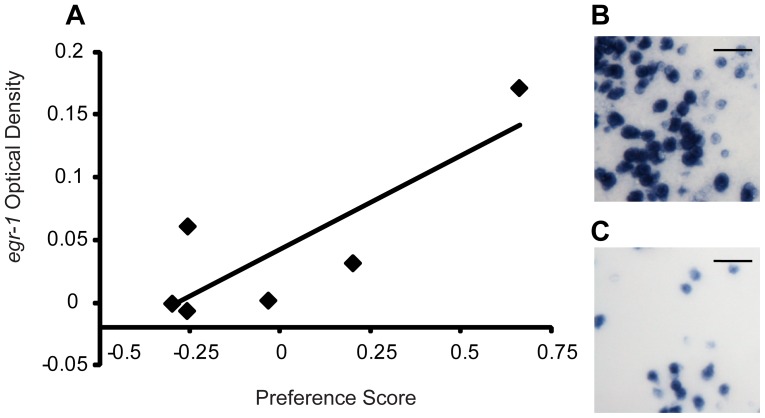
Individual variation of preference score and egr-1 expression.(a) Significant correlation between individual variation in preference score and egr-1 expression in Dm. Representative images of egr-1 expression in Dm for two individuals with a preference score of (B) 0.66 and (C) −0.26. Scale bar is 25 microns.